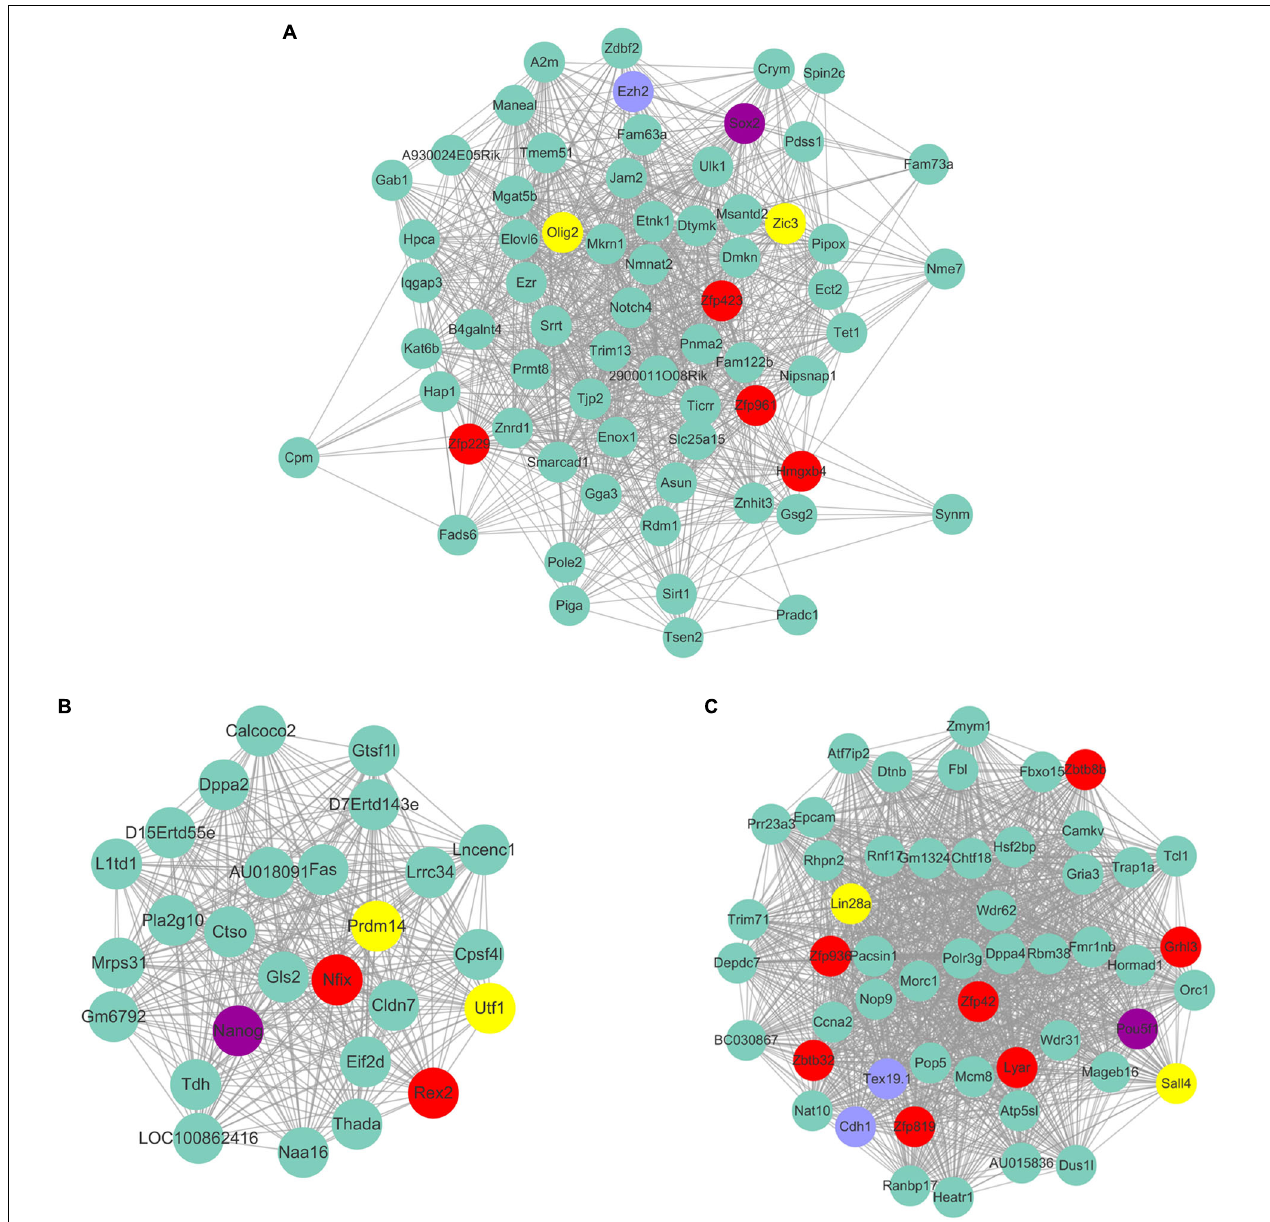
FIGURE 8 | The predicted co-expressed network of Yamanaka factors. The co-expression networks of Yamanaka factors Sox2 (A) , Nanog (B) , and Pou5f1 (C) . Yamanaka factors Sox2, Nanog and Pou5f1 are labeled in purple. Several well-known stemness transcription factors are marked in yellow and non-transcription factors were labeled as blue. The predicted transcription factors within the respective network of respective Yamanaka factors are highlighted in red. For clarity, the top 20% of the nodes of Nanog and Pou5f1 co-expressed genes were displayed according to node